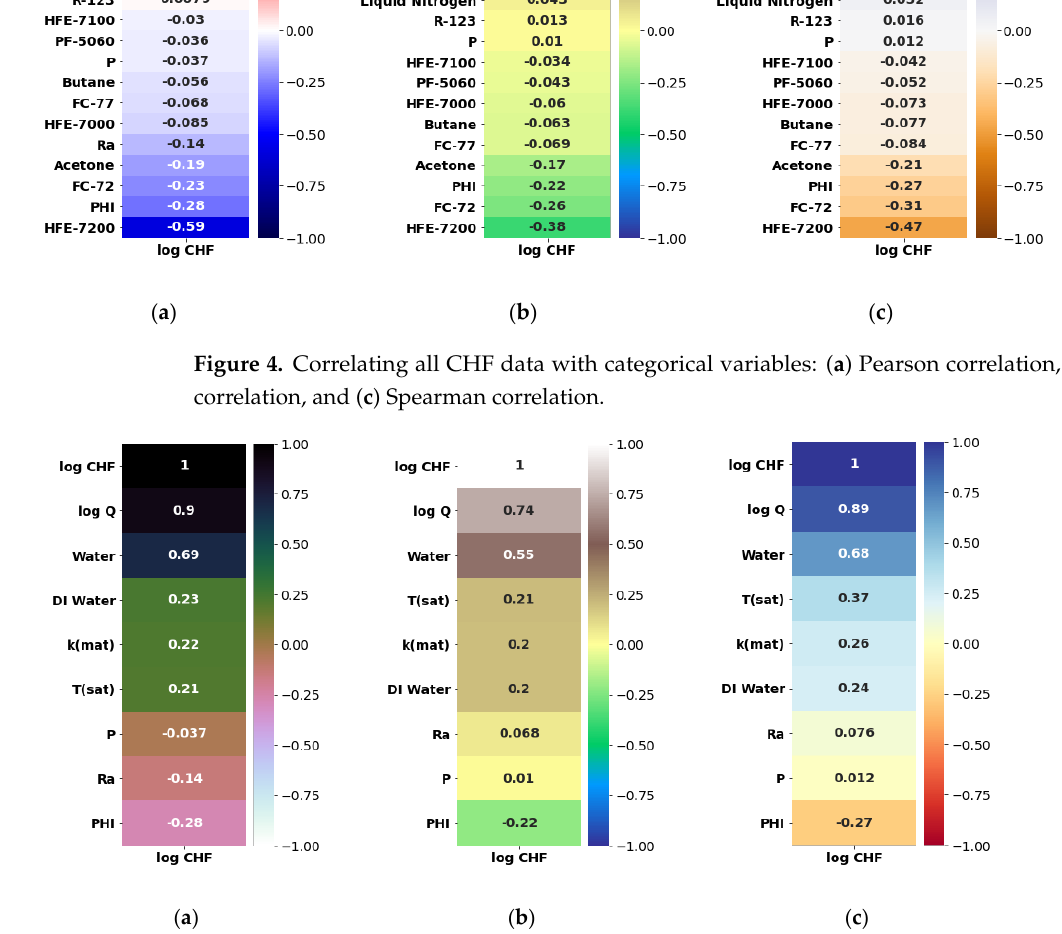
Figure 5. Correlating CHF data of water with categorical variables: ( a ) Pearson correlation, ( b ) Kendal correlation, and ( c ) Spearman correlation.